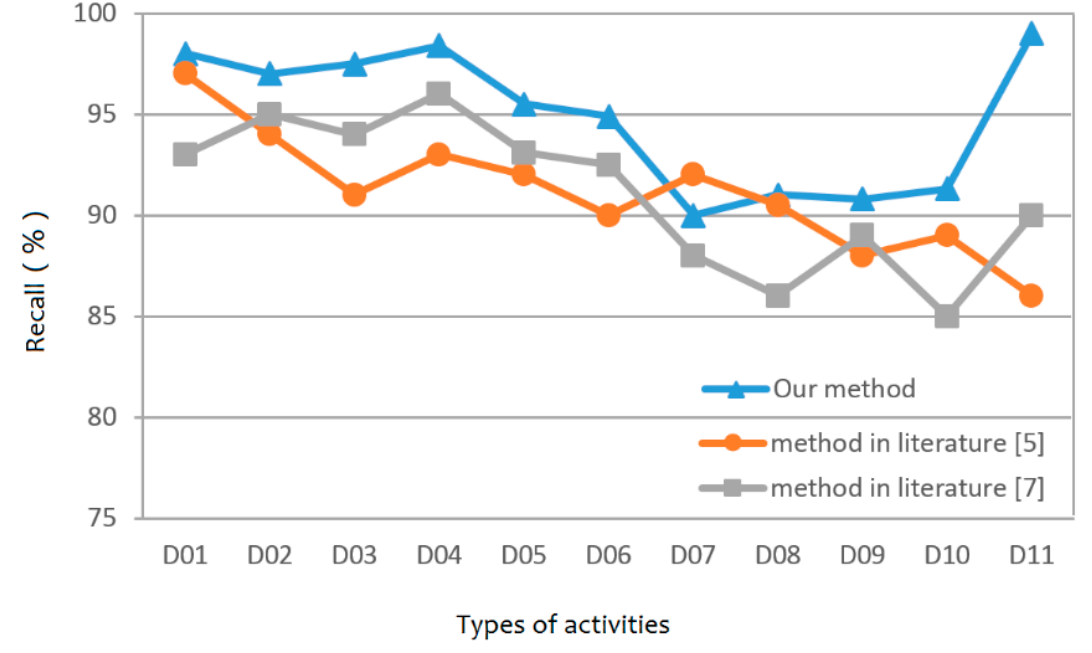
Figure 15. Comparison of different methods.